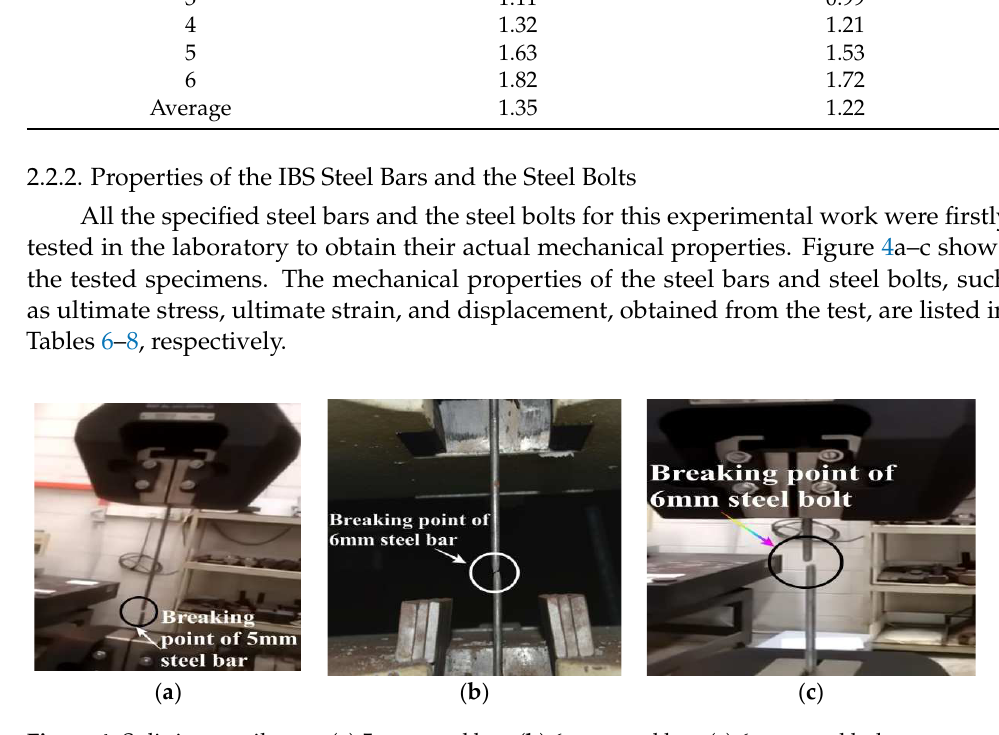
Figure 4. Splitting tensile test: ( a ) 5 mm steel bar; ( b ) 6 mm steel bar; ( c ) 6 mm steel bolt. Table 6. Results for 5 mm-diameter steel bars.